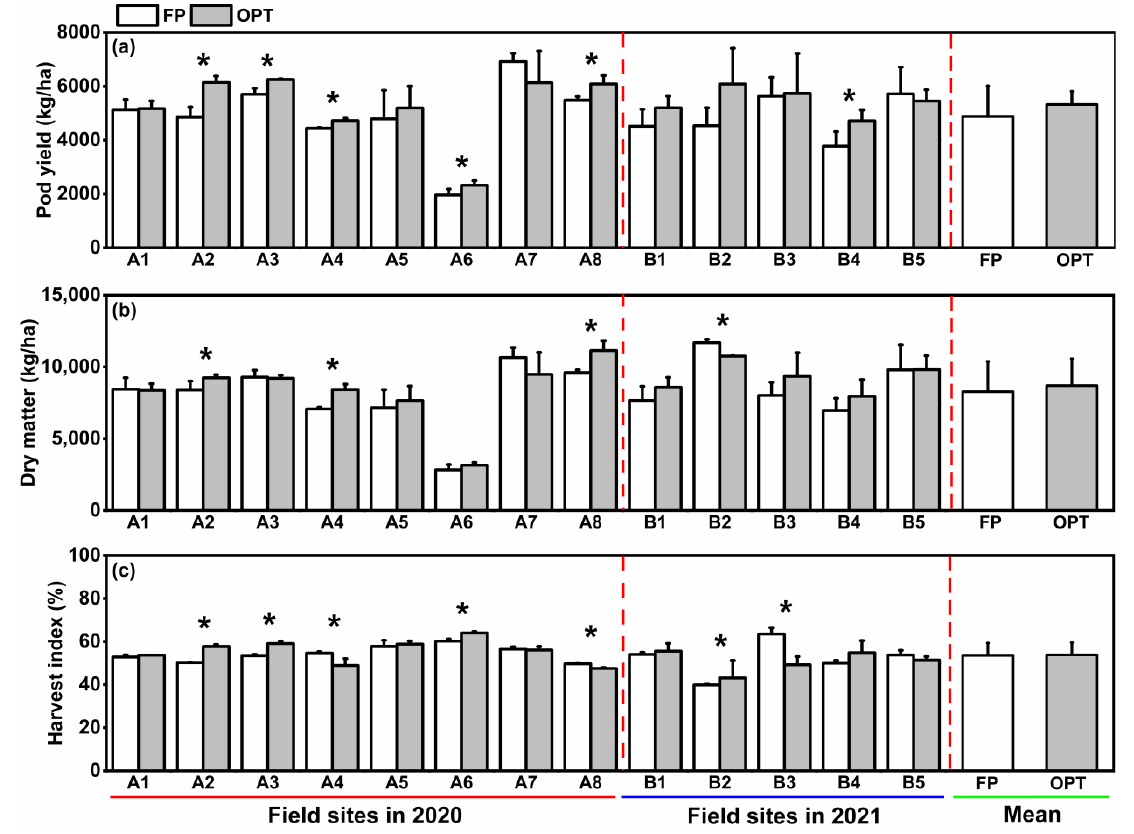
Figure 3. Variations in dry matter (DM, ( a )), pod yield (PY, ( b )), and harvest index (HI, ( c )) of different fertilization treatment at different field sites in 2020 and 2021. FP: farmers’ practice fertilization; OPT: optimized fertilization. A: experiment in 2021; B: experiment in 2022. Tentacle lines on the bars are standard deviation. Asterisks (*) on the bars indicate a significant difference at p < 0.05 between fertilization treatments for the same field site.